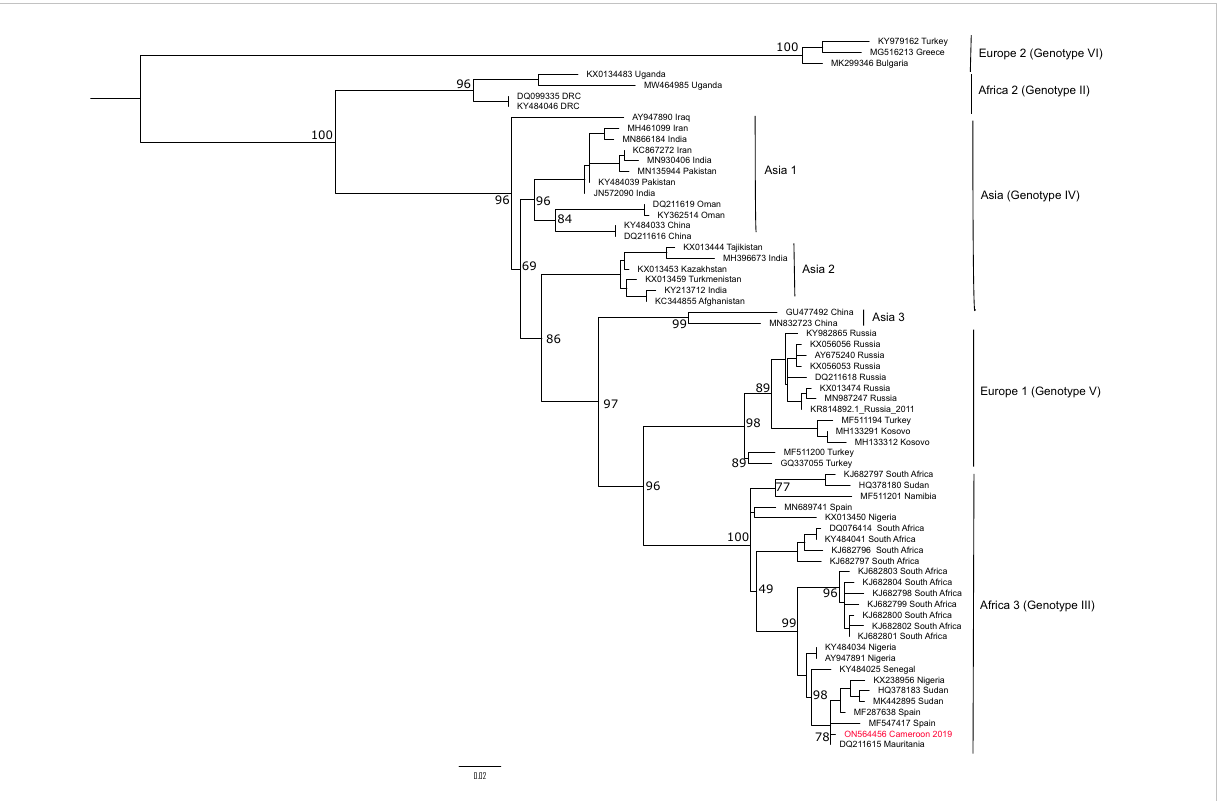
FIGURE 3 Phylogenetic analysis of the L segment of CCHFV from Cameroon. The maximum likelihood tree was constructedon a 445 bp fragment of the L segment under the TIM2+F+I substitution model and 1000 bootstrap resamplings. Bootstraps are shown only for the main nodes. The CCHFV sequence obtained from Cameroon in this study is highlighted in red. The tree was rooted at